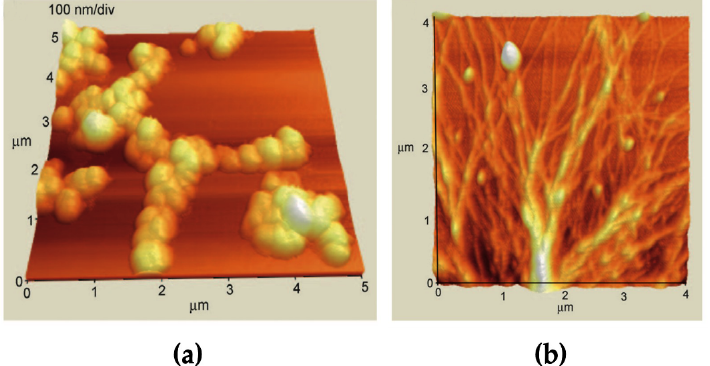
Figure 3. AFM images of porphyrin aggregates layered onto HOPG, formed in EtOH/H 2 O 25/75 v:v. ( a ) H 2 P(L)Pro( − ) ; ( b ) H 2 P(L)Pro(+) . Adapted from [43], with permission from Wiley-VCH, Copyright © 2010.